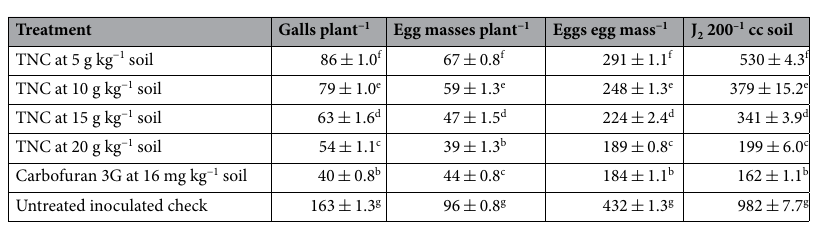
Table 1. Efficacy of T. asperellum FbMi6 enriched neem cake on nematode reproduction parameters of M. incognita in okra. Data are mean of five replicates. INP- 2000 J 2 /kg. Values with the different letter are significant according to DMRT (p < 0.05). Data are presented as means ± SD. TNC T. asperellum FbMi6 enriched neem cake.